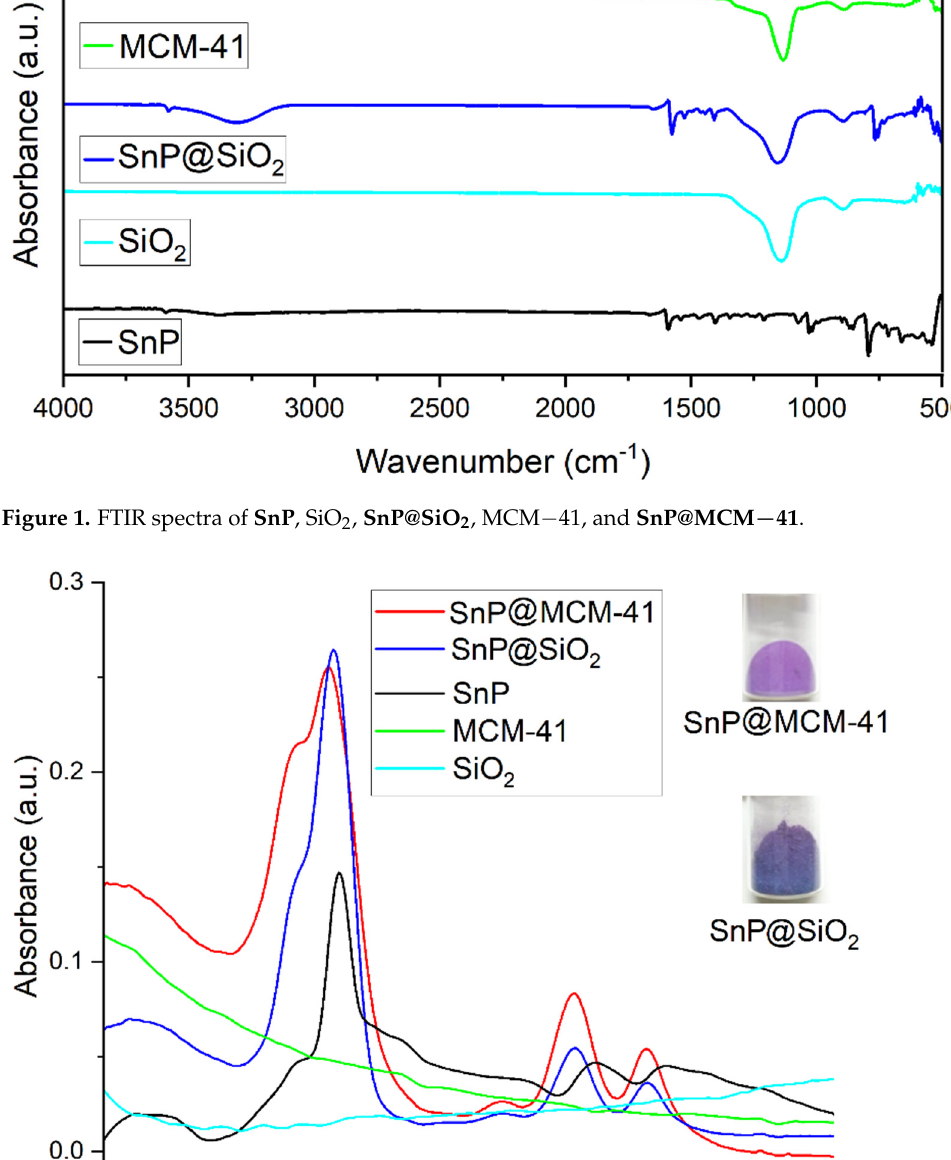
− 41, SnP@MCM − 41 , and SnP@SiO 2 2 , MCM